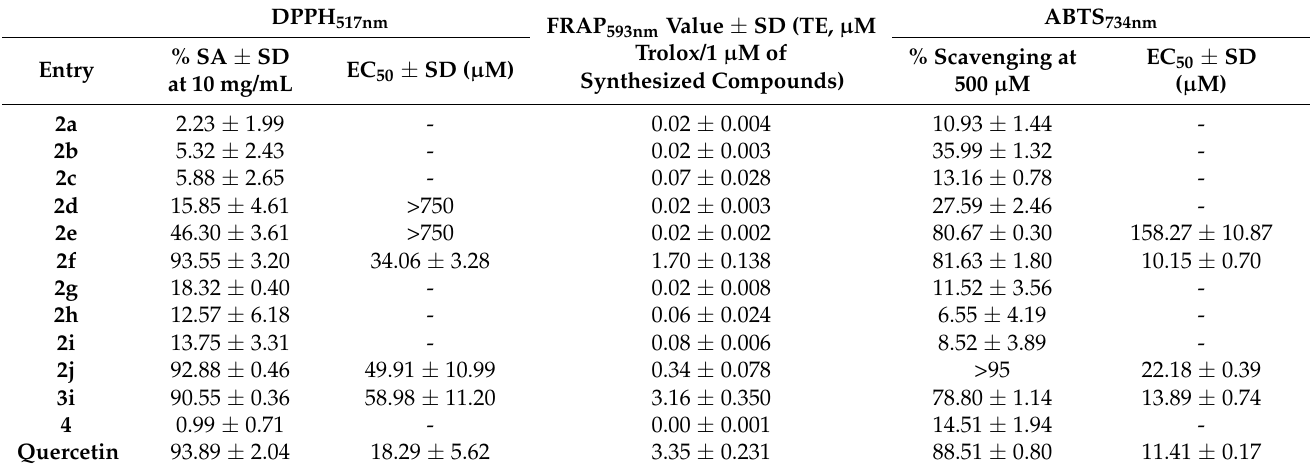
Table 1. The percentage of antioxidant activity using the DPPH, FRAP, and ABTS